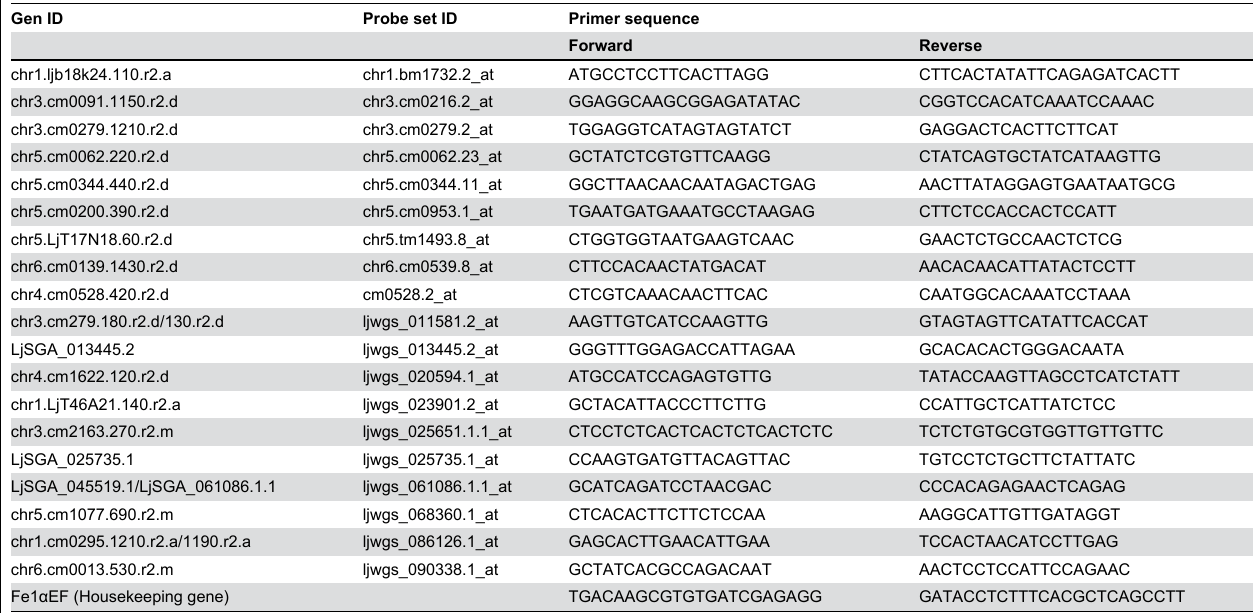
Table 1. Primers used in this